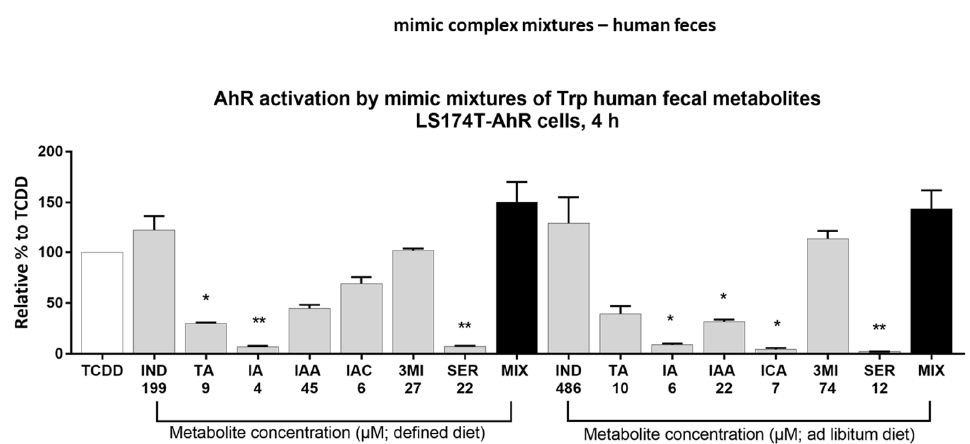
Figure 5. Effect of mimic mixtures of MICTs on AHR activity. LS174T-AHR-luc cells were incubated for 4 h with vehicle (DMSO; 0.2% v / v ), TCDD (20 nM), and MICTs alone or in the mimic mixture. The concentration of each compound equals the observed mean quantified in human fecal samples [30]. The effects of tested compounds are expressed as a percent of induction of luciferase activity